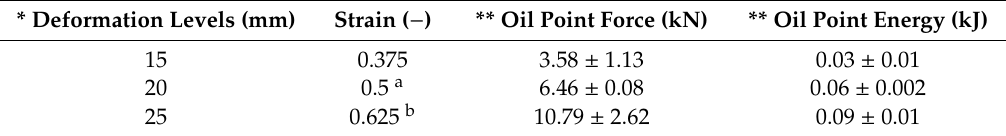
* For initial pressing height, H = 40 mm; a Lower oil point; b Upper oil point; ** (Control at 25 ◦